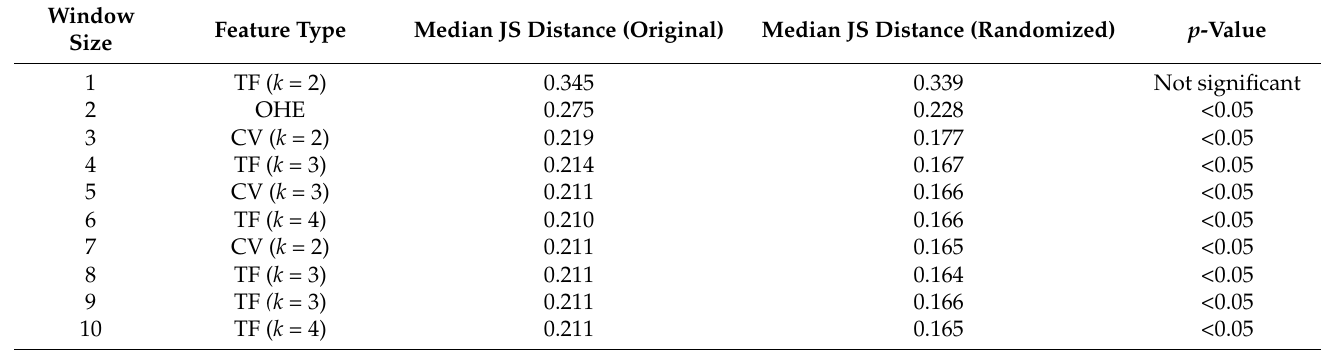
Table 1. Median JS distances for both the original and randomized experiments for different window sizes.